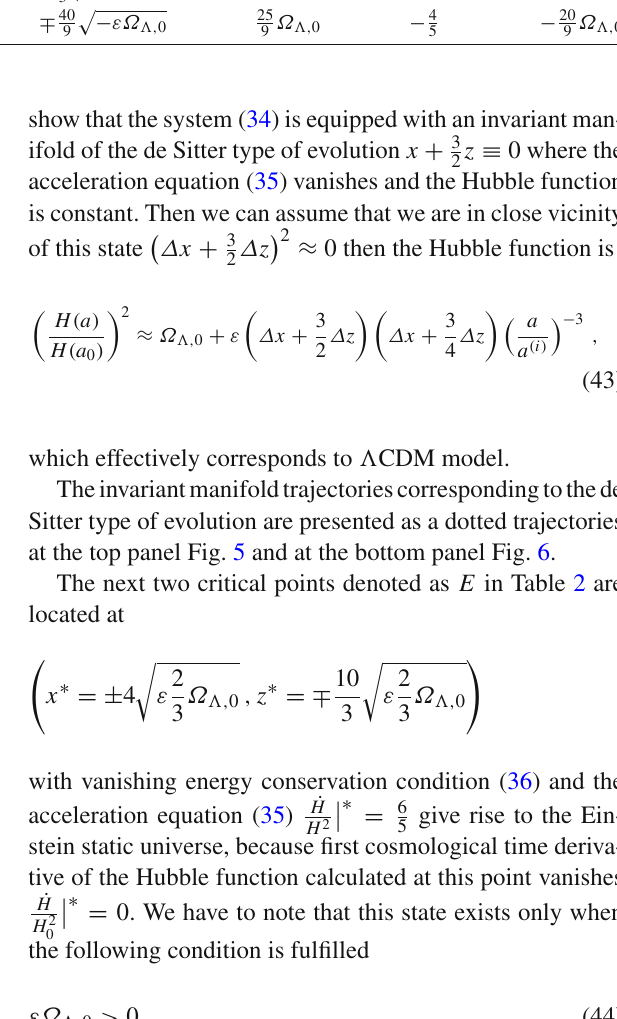
Table 2 The critical points of the system (38) and corresponding values of the Hubble function (36) and the acceleration equation